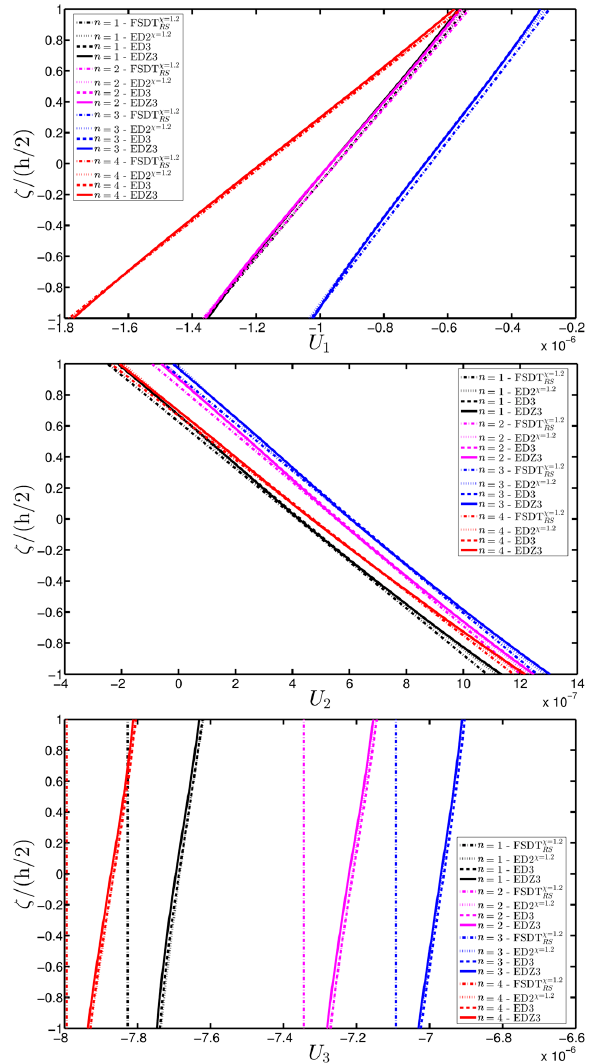
Figure 27. Through-the-thickness profiles of displacement components [m] for the CCCF doubly-curved panel of revolution computed at the point C for different HSDTs. The effect of the damage is investigated by varying the parameters of the function Gau-6.